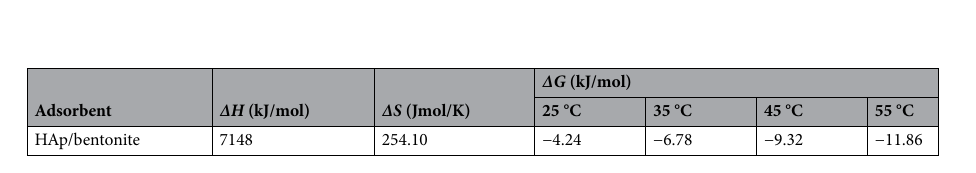
Figure 9. Adsorption thermodynamics of Cd(II) onto HAp/bentonite composite.